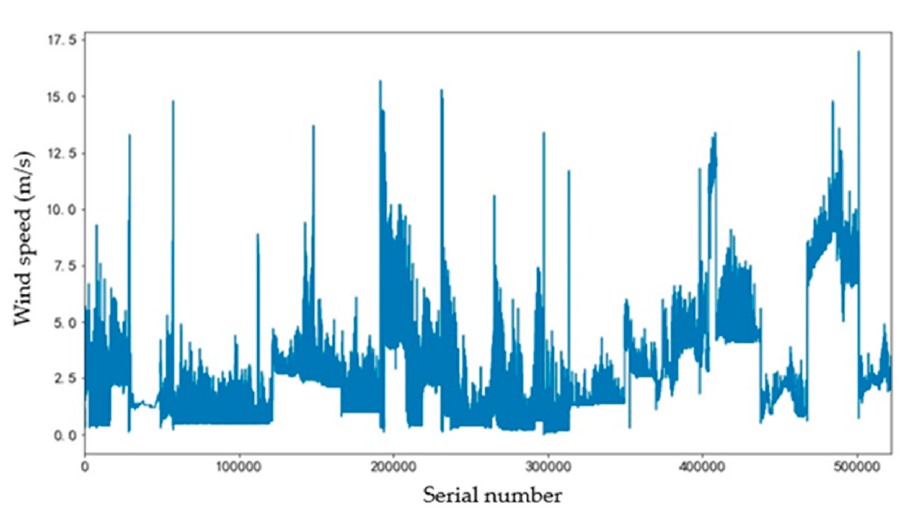
Figure 6. Wind speed data.